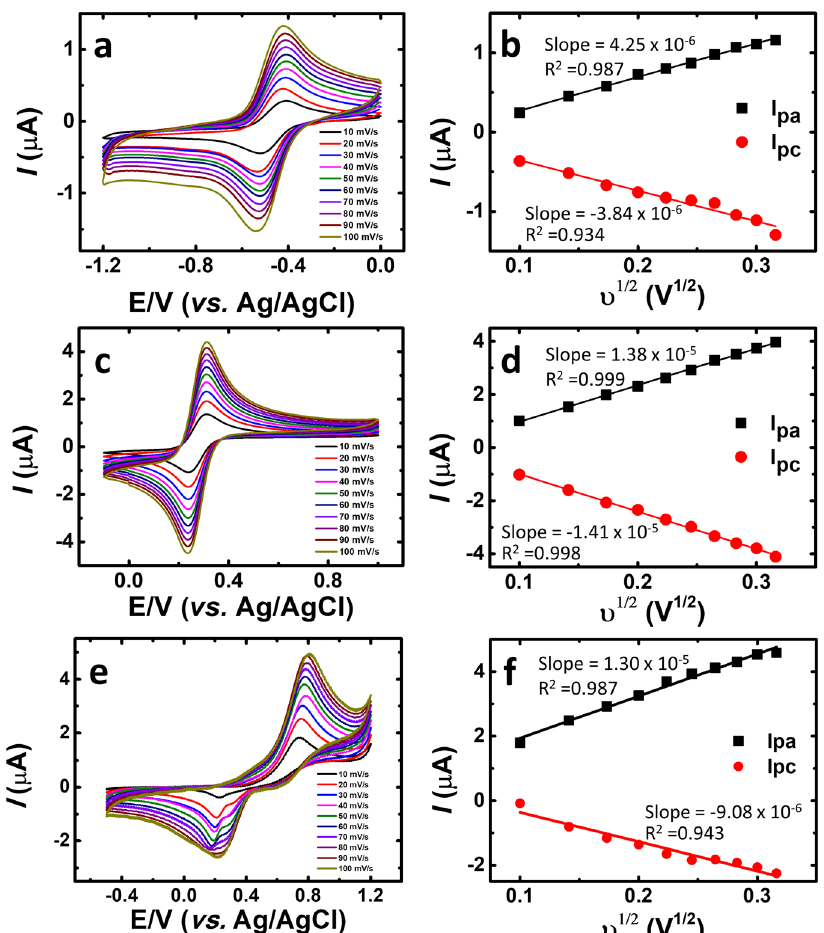
Fig. 3 Determination of diffusion coef fi cient ( D ). Cyclic voltammetry scan rate study obtained with saturated N 2 at various scan rates (10 – 100 mV s − 1 ) in 1.0 M KCl solution of electrolyte. a 1.0 mM TRYP-SO 3 H at various scan rates. b plot of i p a and i p c over the square root of scan rates for 1.0 mM TRYP-SO 3 H. c 1.0 mM K 4 [Fe(CN) 6 ]·3H 2 O at various scan rates. d plot of i p a and i p c over the square root of scan rates for 1.0 mM K 4 [Fe(CN) 6 ]·3H 2 O. e 1.0 mM BQDS at various scan rates. f plot of i p a and i p c, over the square root of scan rates for 1.0 mM BQDS. In b , d , and f black squares and line for oxidative reaction and red squares and line for reductive